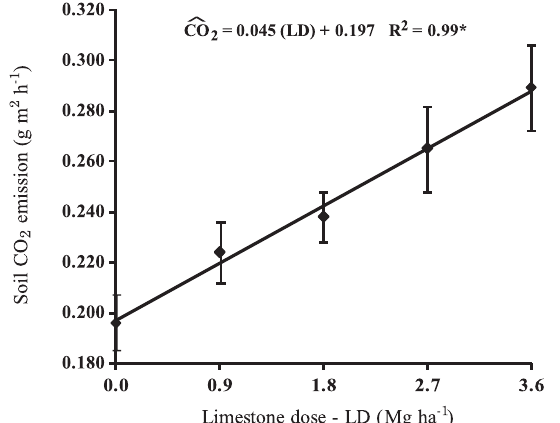
figure 1. linear regression model for lime rates and soil co 2 emission, two years after liming without moldboard plowing. * significantly different (p < 0.10). error bars represent one standard error of the